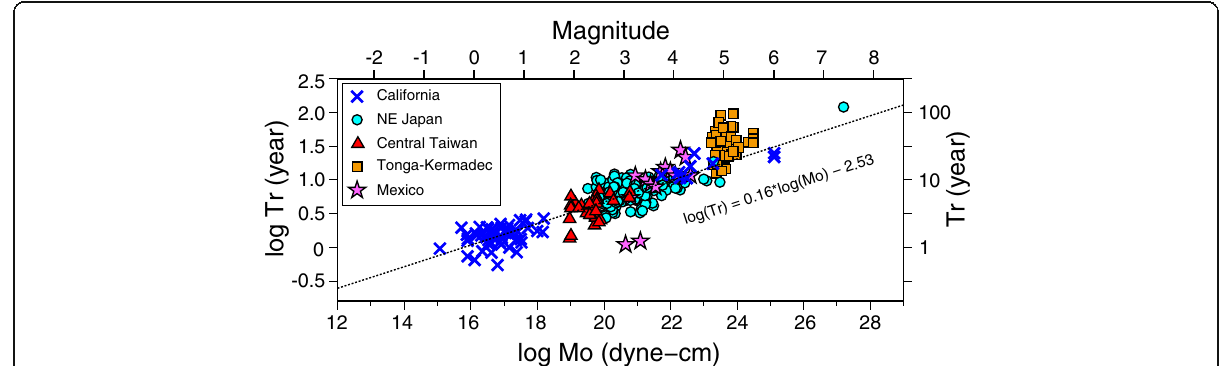
Fig. 10 Comparison of the relationship between the sequence-averaged recurrence interval (Tr) and seismic moment (Mo) for different study areas. Please note that the recurrence interval is normalized by the ratio of plate convergence rates between California and other regions. The original figures and details can be found in Nadeau and Johnson (1998) (San Andreas fault), Chen et al. (2007) (Central Taiwan), Yu (2013) (Tonga- Kermadec), and Dominguez et al. (2016) (Mexico). For NE Japan, only the data before the Tohoku-oki earthquake and sequences with 8 or more recurrences are selected from the catalog of Uchida and Matsuzawa